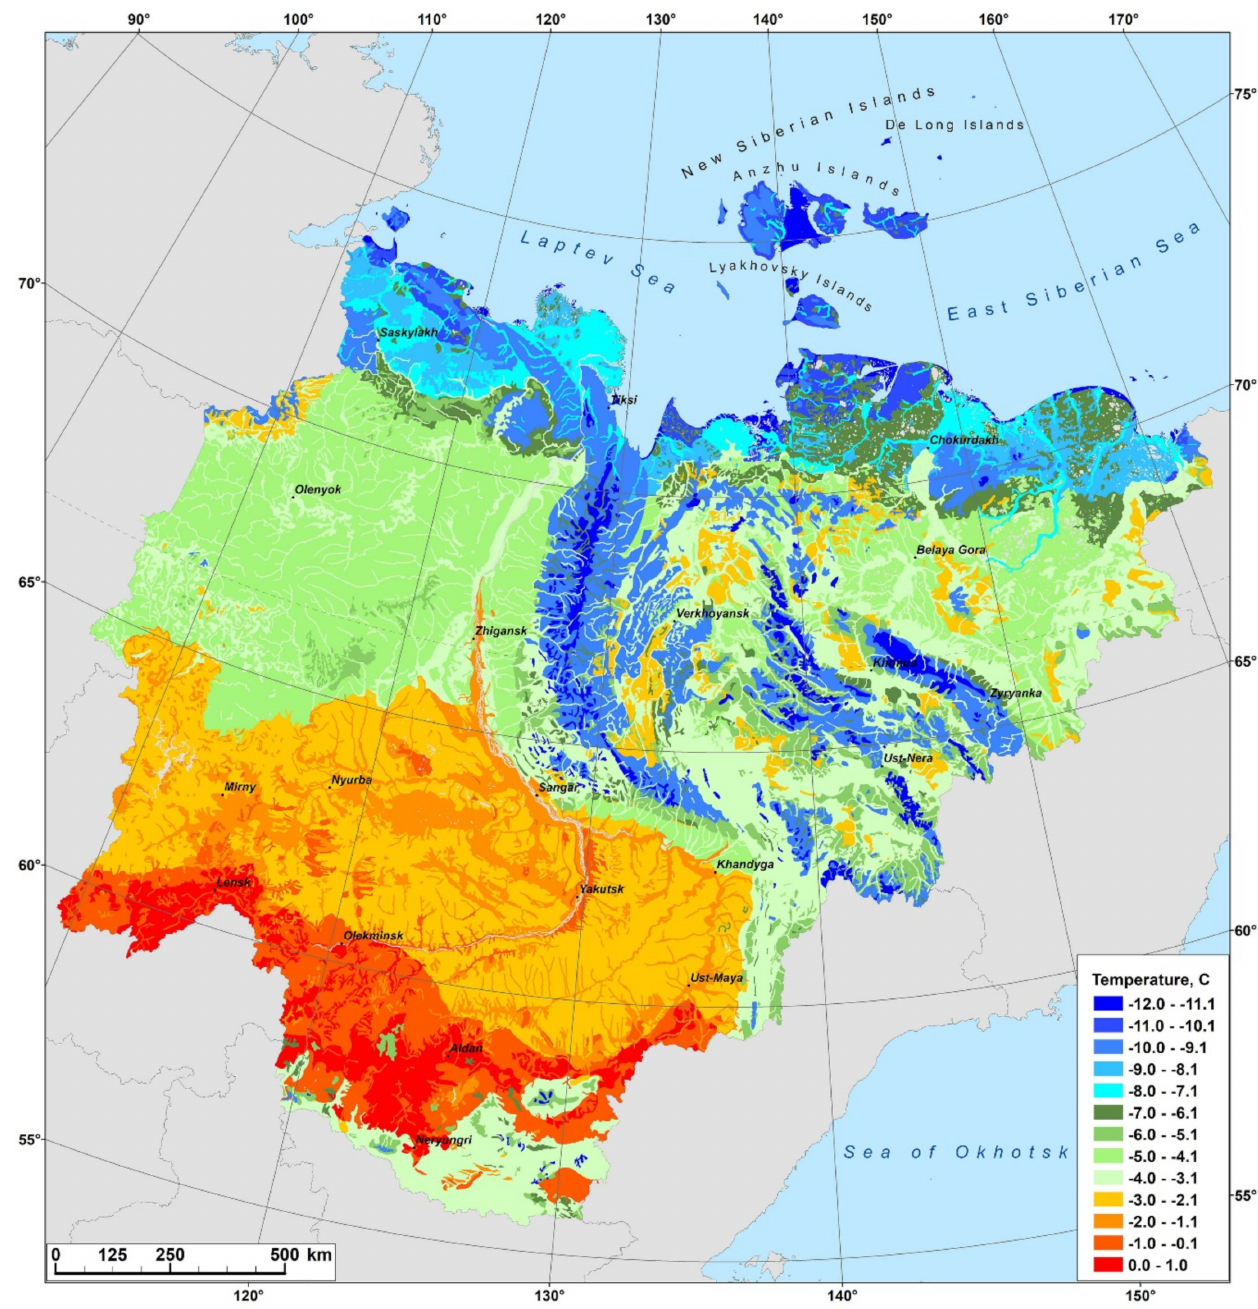
Figure 3. Map of ground temperature at the depth of zero annual amplitude. Low temperatures below − 6 ◦ C were found to mainly be typical in the tundra zone, mountain tundra, and desert in mountain structures, occupying about 23.2% of the territory of Yakutia. Landscapes with the seasonally frozen ground (Tg > 0 ◦ C) made up only 3.6% of the region, mainly occupied by pine and pine–larch forests on the plateau in Southwestern and Southern Yakutia. Such a distribution of permafrost temperature indicated the diversity of permafrost landscapes in Yakutia. On the map (see Figure 3, high- resolution map, see Supplementary S2), one can see regional and intraregional landscape differences in ground